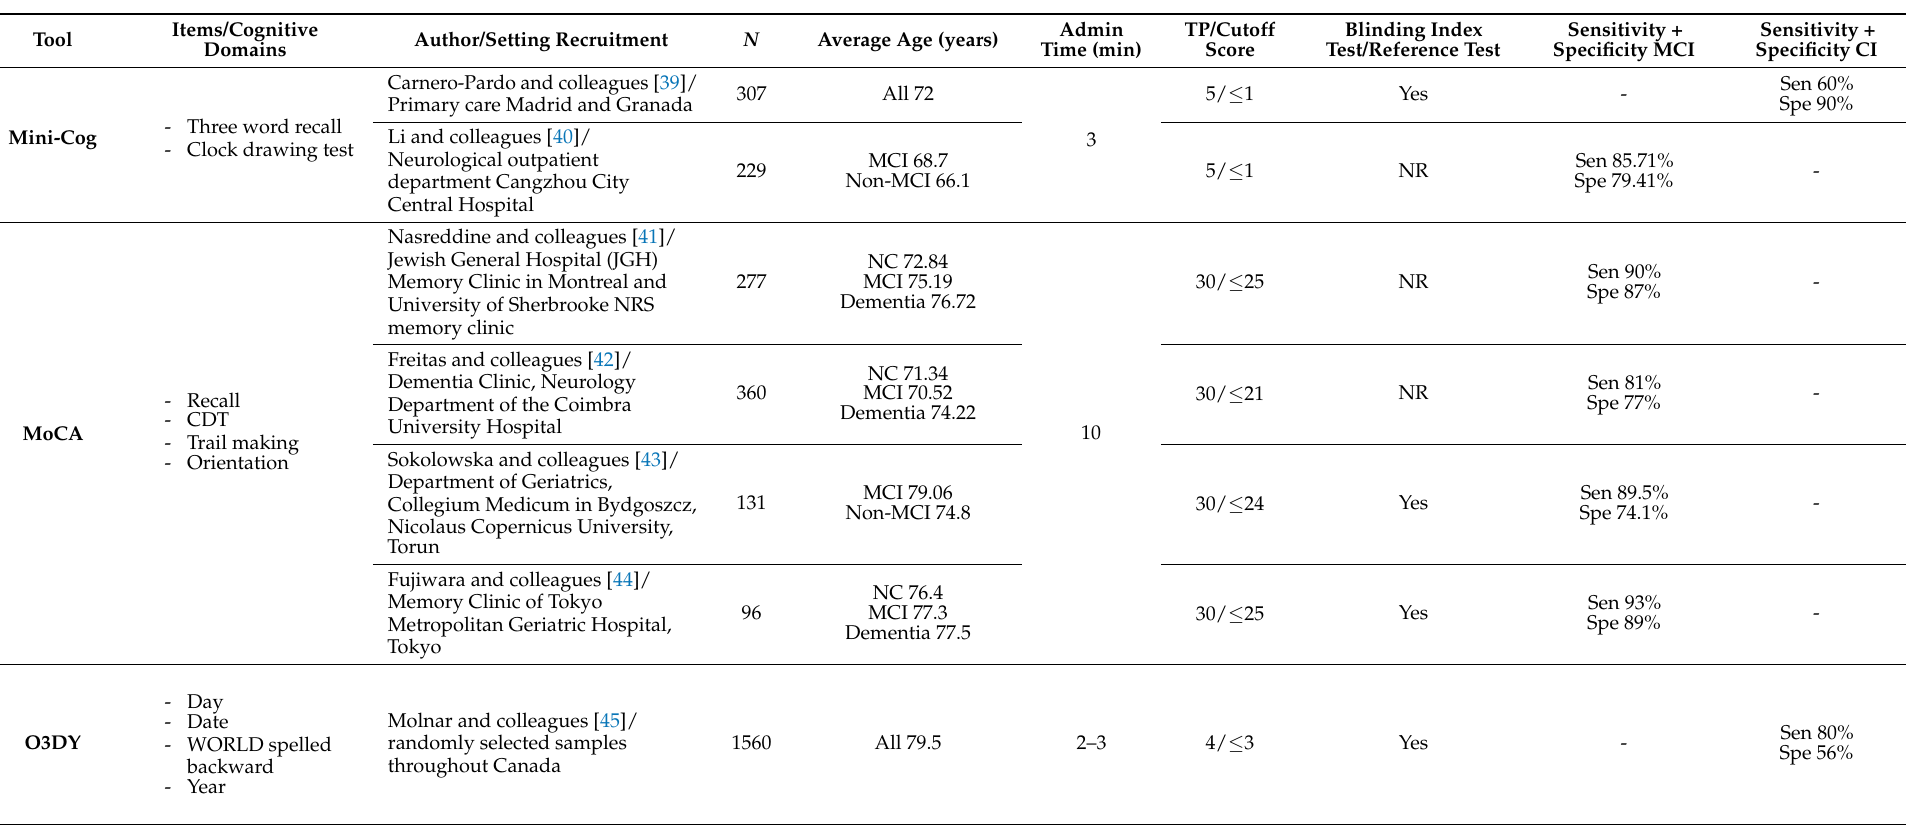
Table 2. This table shows a summary and comparison of the included cognitive screeners and the available literature. MCI = Mild Cognitive Impairment, CI = Cognitive Impairment (MCI + Alzheimer Disease), NR = Not Reported. * Cut off ≤ 23.5 for a population with less than high school education. Cut off <25.5 for a population with higher education. ** Only applicable to the modified TICS